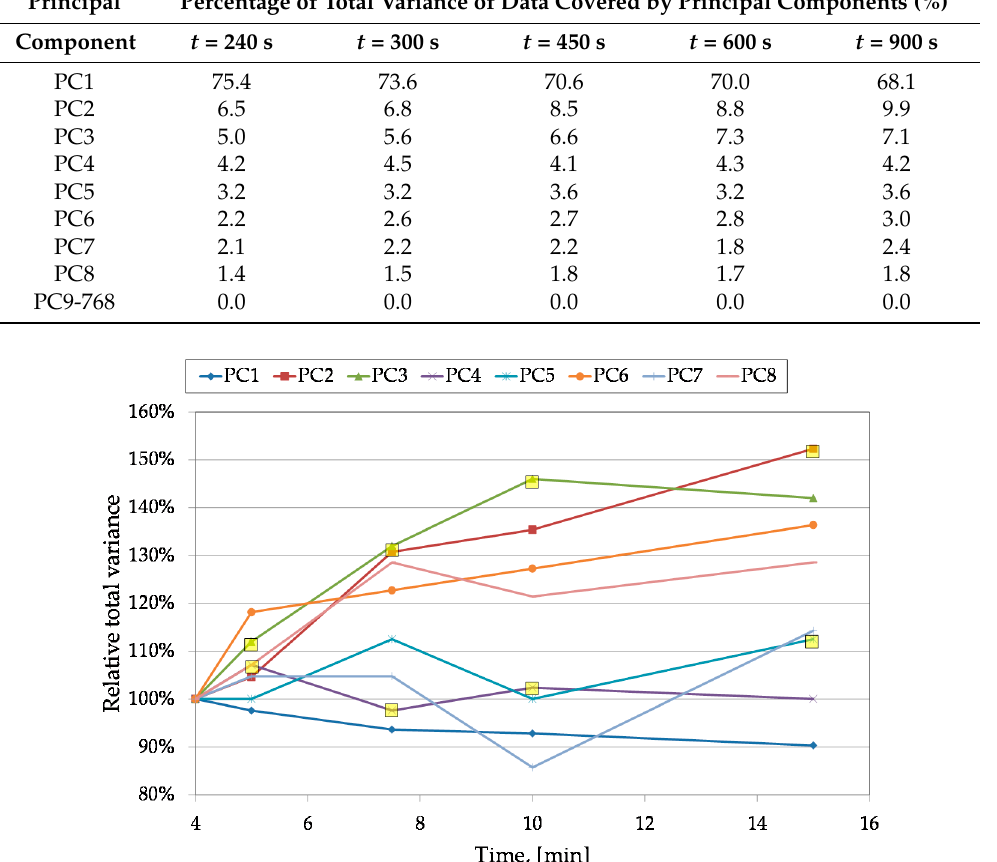
Figure 13. Relative changes of total variance for PC1–PC8 as functions of the acquisition time.